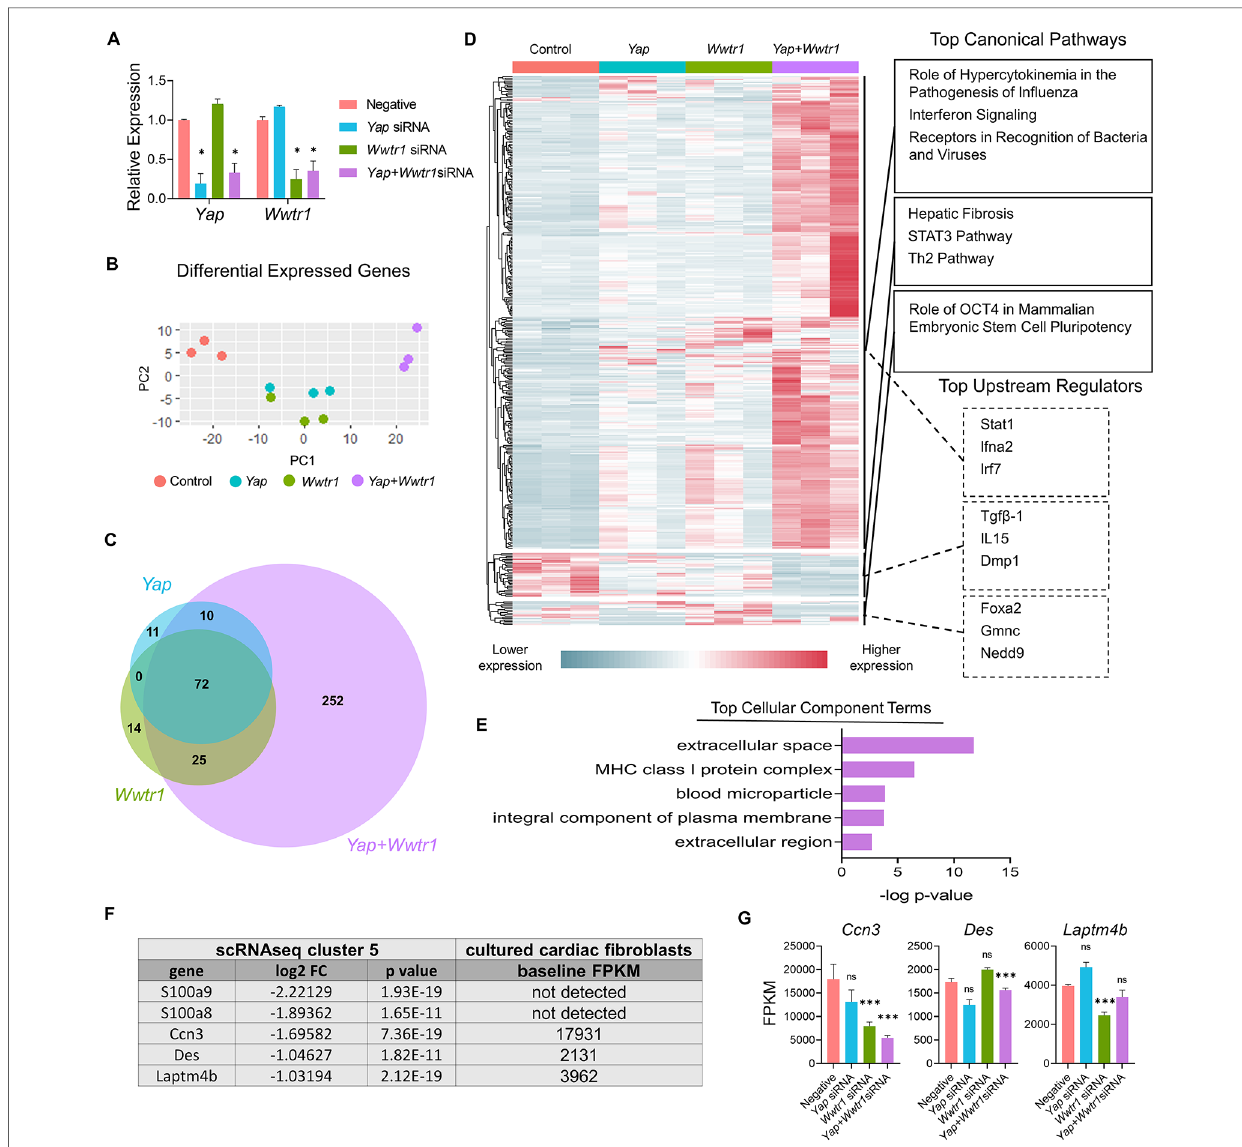
FIGURE 5 Gene expression following Yap and/or Wwtr1 depletion in vitro . ( A ) Relative RNA expression of Yap and Wwtr1 after siRNA knockdown in primary cardiac fi broblasts. n =3 negative control, n =4 Yap , n =4 Wwtr1 , n =4 Yap + Wwtr1 . Each data point represents a biological replicate derived from cells from independent pooled litters. One-way ANOVA comparing experimental groups to negative siRNA control by Dunnett ’ s test. ( B ) PCA of DEGs from RNAseq from siRNA treated cells n =3 per group. ( C ) Venn Diagram denoting unique and common DEGs with pAdj <0.05 and log2FC >2 or < − 2 from Yap , Wwtr1, and Yap/Wwtr1 knockdown ( D ) Heat map showing relative DEGs with pAdj <0.05 and log2FC >2 or < − 2. The top three canonical pathways and top three upstream regulators identi fi ed for each gene cluster by IPA are listed. ( E ) The top cellular component terms derived from genes uniquely differentially expressed after Yap/Wwtr1 knockdown. ( F ) Table depicting the top downregulated differentially expressed genes between Yap fl / fl ;Wwtr1 fl /+ ;Postn MCM and Postn MCM fi broblasts and the baseline expression in FPKM values for negative siRNA treated primary cardiac fi broblasts. ( G ) FPKM values of the genes depicted in ( F ) following siRNA treatment. Ns, not signi fi cant, * P <0.05, and *** P